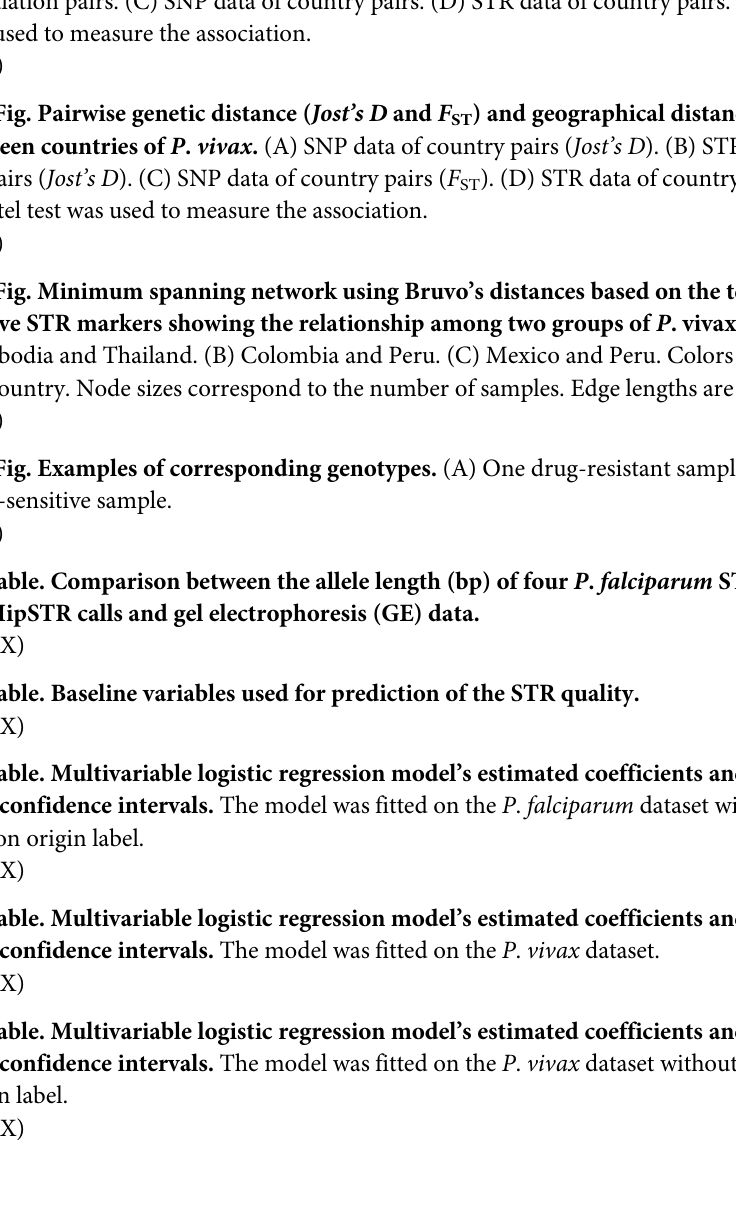
S16 Fig. A comparison of measures of genetic differentiation ( Jost’s D and F ) estimates ST using SNP and STR data of P . vivax . (A) Jost’s D of country pairs ( Mantel r = 0.9678, P = 0.001). (B) F ST of country pairs ( Mantel r = 0.9185, P = 0.001). Mantel tests were used to measure the correlation. S17 Fig. Pairwise genetic distance ( Jost’s D ) and geographical distances (km) between pop- ulations and countries of P . falciparum . (A) SNP data of population pairs. (B) STR data of population pairs. (C) SNP data of country pairs. (D) STR data of country pairs. A Mantel test was used to measure the association. (TIF) S18 Fig. Pairwise genetic distance ( Jost’s D and F ) and geographical distances (km) ST between countries of P . vivax . (A) SNP data of country pairs ( Jost’s D ). (B) STR data of coun- try pairs ( Jost’s D ). (C) SNP data of country pairs ( F ). (D) STR data of country pairs ( F ). A ST ST Mantel test was used to measure the association. (TIF) S19 Fig. Minimum spanning network using Bruvo’s distances based on the ten most infor- mative STR markers showing the relationship among two groups of P . vivax isolates. (A) Cambodia and Thailand. (B) Colombia and Peru. (C) Mexico and Peru. Colors correspond to the country. Node sizes correspond to the number of samples. Edge lengths are arbitrary. (TIF) S20 Fig. Examples of corresponding genotypes. (A) One drug-resistant sample. (B) One drug-sensitive sample. (TIF) S1 Table. Comparison between the allele length (bp) of four P . falciparum STR markers for HipSTR calls and gel electrophoresis (GE) data. S2 Table. Baseline variables used for prediction of the STR quality. S3 Table. Multivariable logistic regression model’s estimated coefficients and respective 95% confidence intervals. The model was fitted on the P . falciparum dataset without the pop- ulation origin label. S4 Table. Multivariable logistic regression model’s estimated coefficients and respective 95% confidence intervals. The model was fitted on the P . vivax dataset. (XLSX) S5 Table. Multivariable logistic regression model’s estimated coefficients and respective 95% confidence intervals. The model was fitted on the P . vivax dataset without the population origin